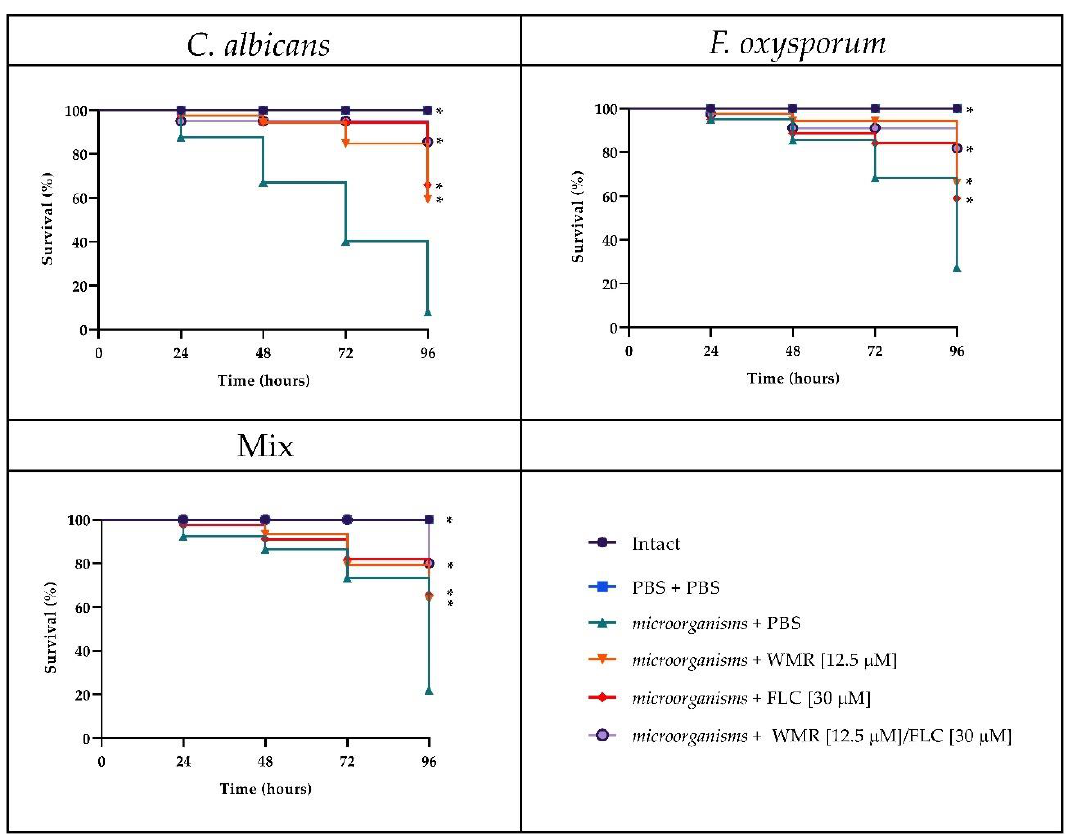
Figure 8. Survival curve of G. mellonella infected with C. albicans , F. oxysporum , and the mix of the two pathogens, treated with WMR and FLC and their combination. * indicates significant difference ( p < 0.05, Tukey’s test).